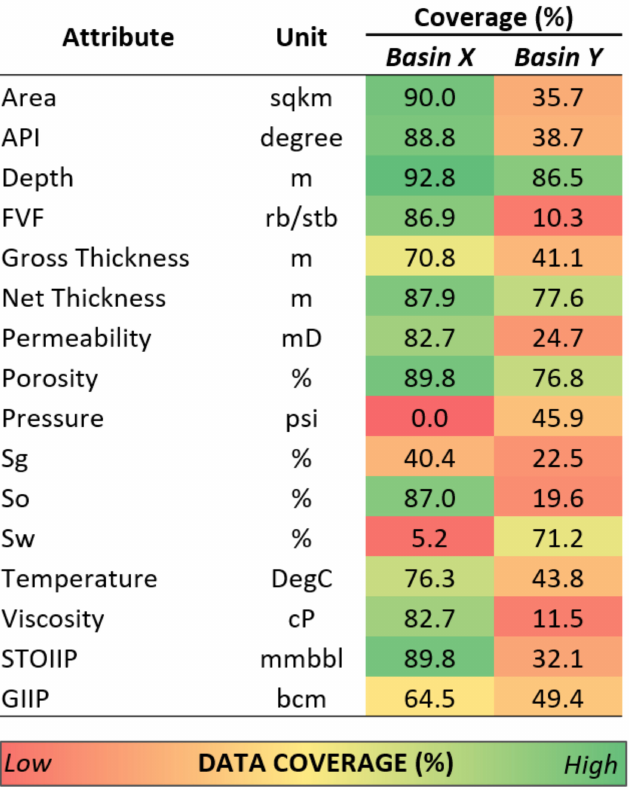
Figure 1. Attributes used in this study and their % data coverage across Basin X and Basin Y